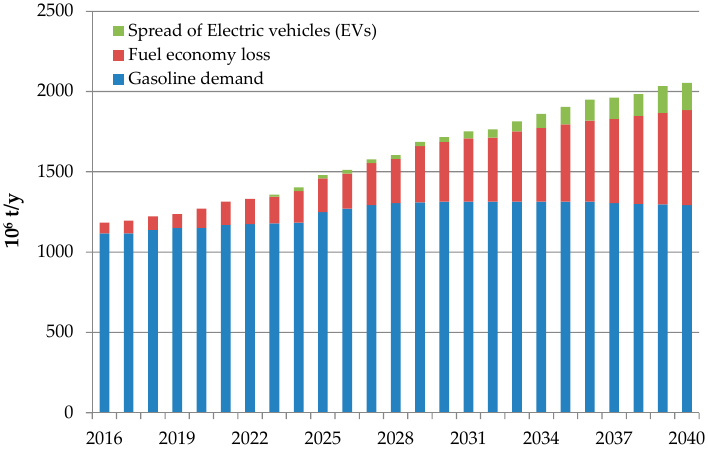
Figure 2. ( a ) Global energy mix by engine fuels. ( b ) Energy demand by type of transportation.